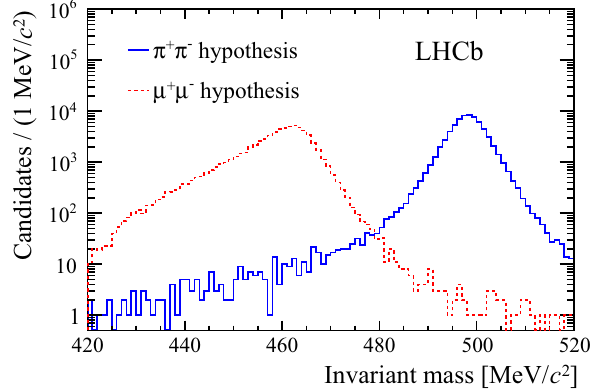
→ π + π − decays in trigger- Fig. 1 Reconstructed mass for K 0 S unbiased events, computed assuming the muon (dashed red line) or pion (solid blue line) mass for the final-state tracks. Candidates satisfy the selection criteria described in the